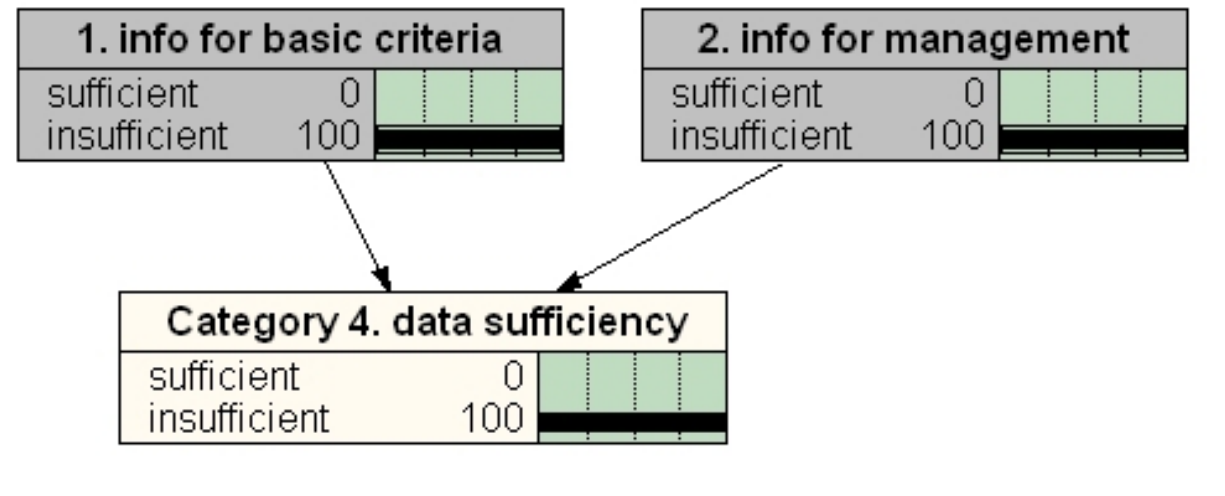
Fig. 5. Bayesian belief network (BBN) submodel for determining evaluation category 4, data sufficiency. See Table 2 for Record of Decision guidelines used to develop this